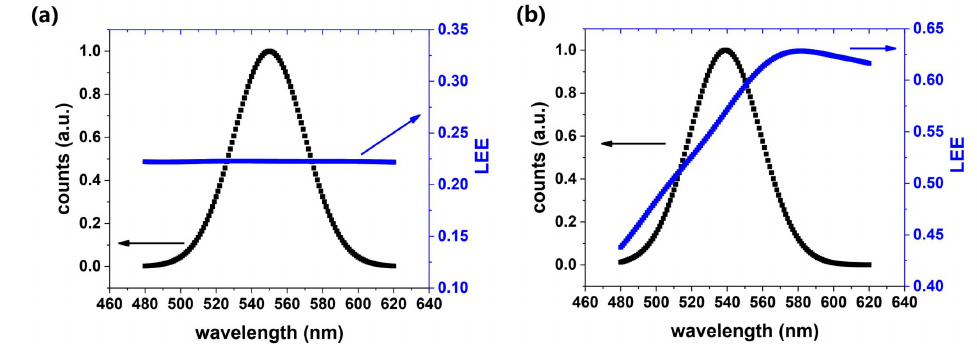
Figure 6. FDTD simulation results of LEE (blue line) and spectra given by Gaussian approximation (black line): ( a ) conventional ( b ) nanorod